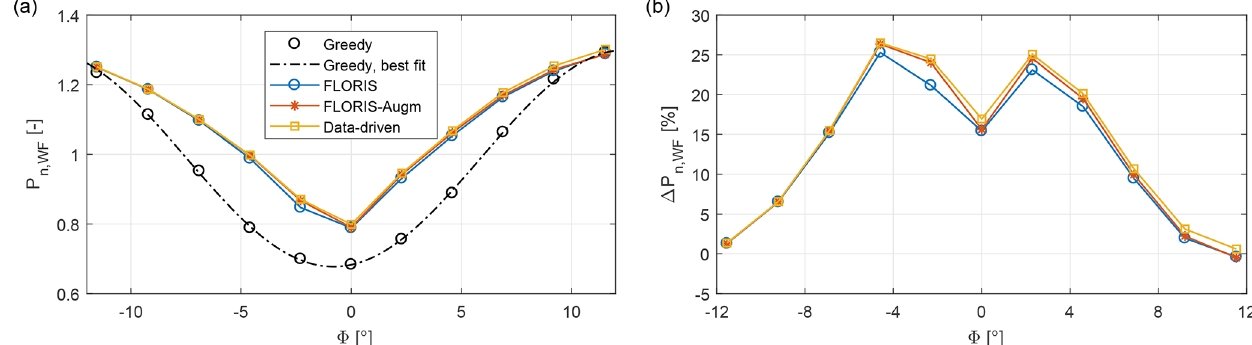
Figure 10. (a) Wind farm power output as a function of wind direction for different control policies. (b) Maximum theoretical percent power gain with respect to the greedy policy for the three flow